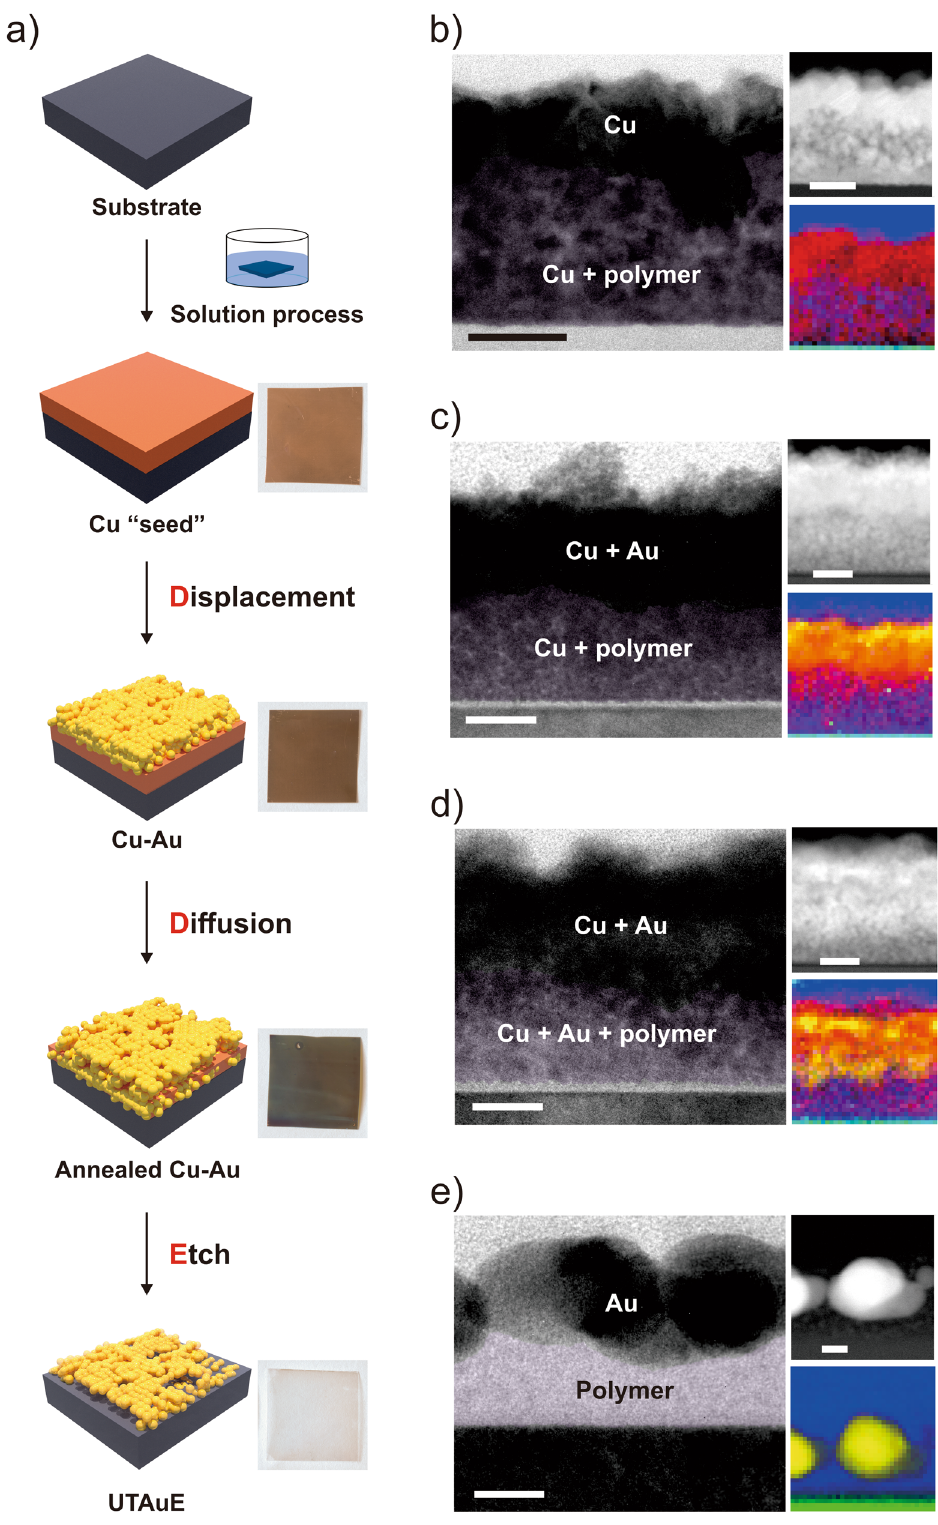
Fig. 1 Fabrication of the UTAuE. a Schematics of the fabrication process of the UTAuE. b – e Cross-sectional TEM (left), HAADF-STEM (top right), and EELS/EDX mapping (bottom right) images of sacri fi cial Cu seed, Cu – Au, annealed Cu – Au, and UTAuE, respectively. Green, blue, red, and yellow represent Si, C, Cu, and Au elements on the elemental mapping images, respectively. Scale bars are 50, 20, 20, and 10 nm for b – e ,